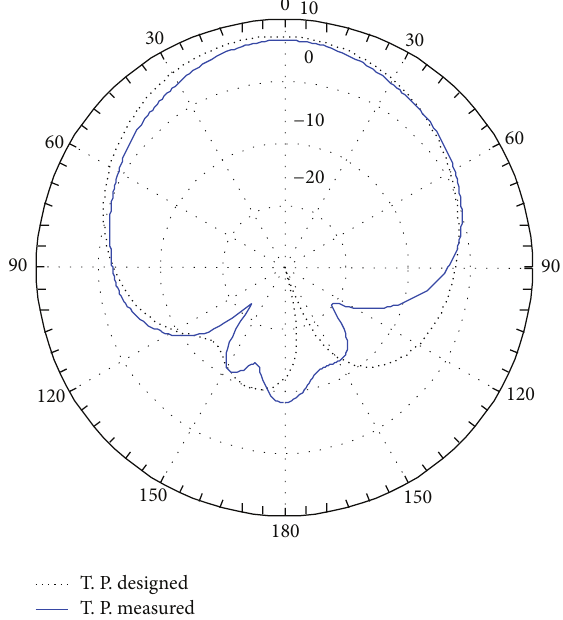
Figure 6: Simulation and measurement results for 𝐸 -plane gain of traditional patch with quarter-wave transformer (frequency: 5.38